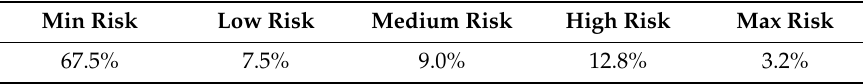
Table 2. Classification of respondents into asset allocation